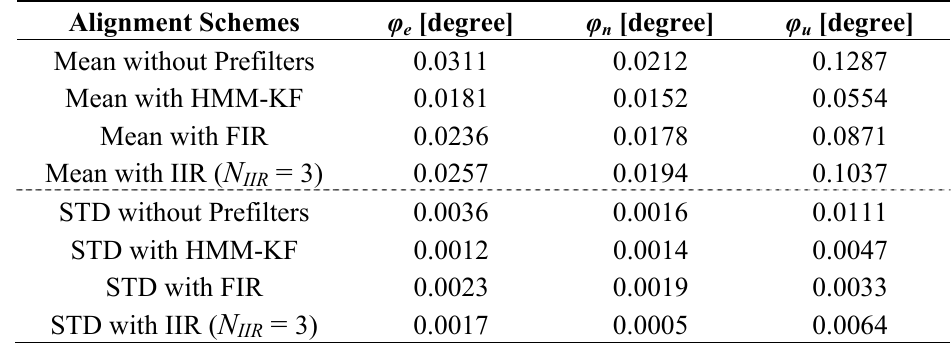
Table 10. Mean and STD of the misalignment angles using the four alignment schemes.